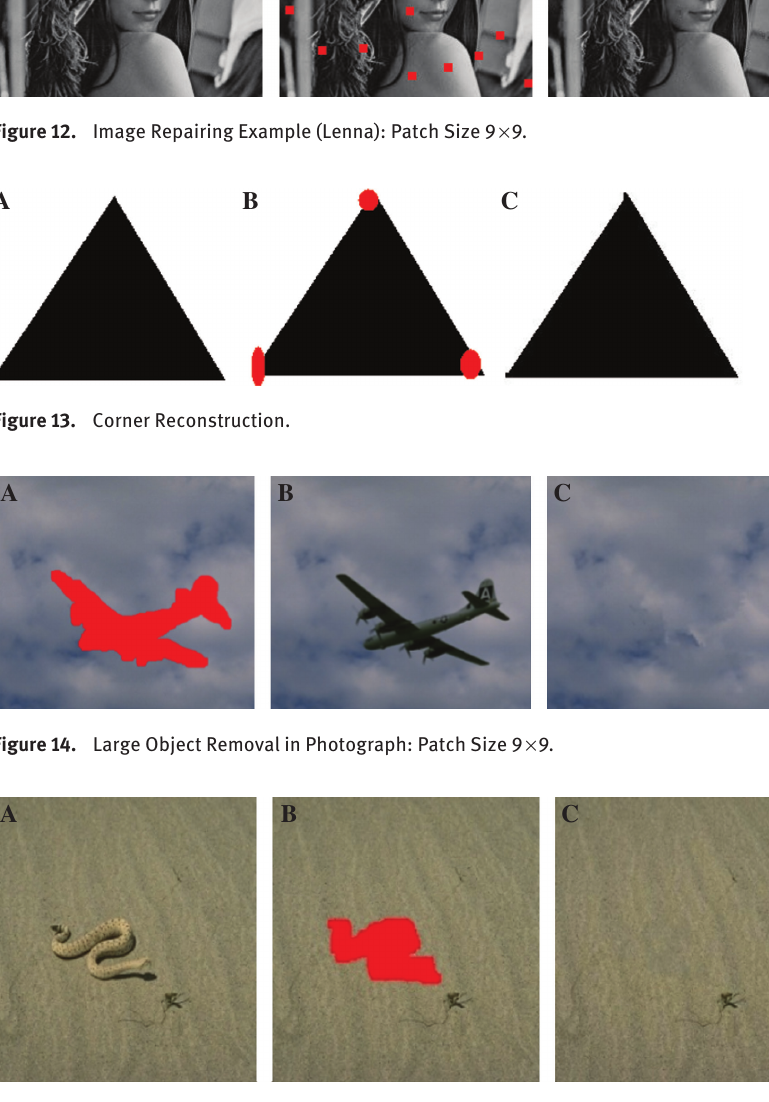
Figure 15. Removing an Object on a Highly Textured Background: Patch Size 9 ×